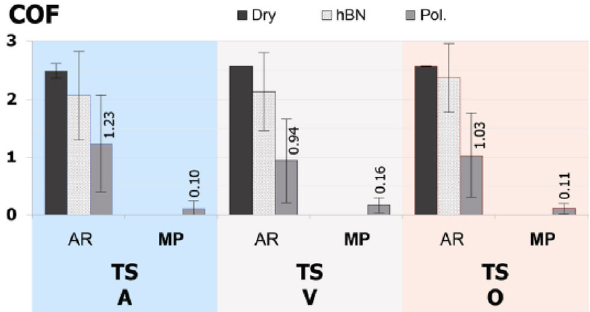
Fig. 46 Average friction levels over the last 25 s of tribotests for all test configurations (load: 10 N, stroke length: 4 mm, frequency 12.5 Hz, temperature: 300 ºC) [803]. Reproduced with permission from Ref. [803], © The author(s), 2021.